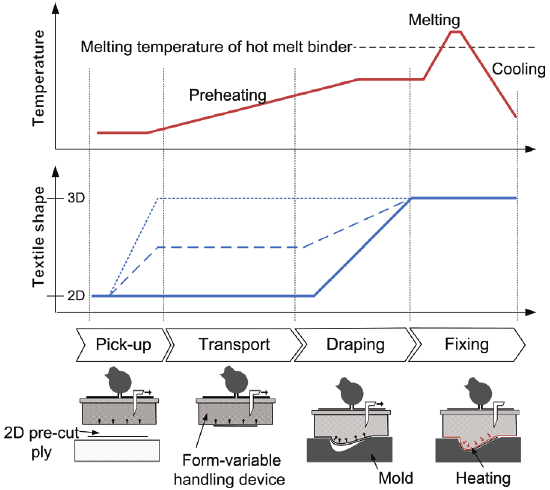
Figure 5 Process timeline with temperature